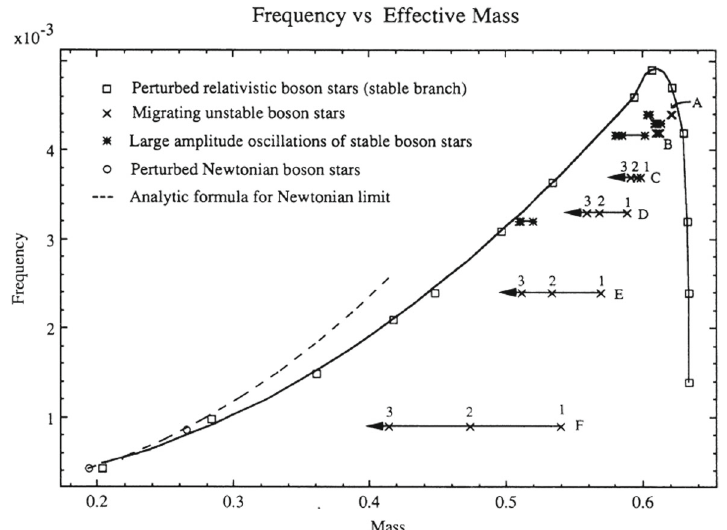
Fig. 12 Oscillation frequencies of various boson stars are plotted against their mass. Also shown are the oscillationfrequenciesofunstableBSsobtainedfromthefullynonlinearevolutionofthedynamicalsystem. Unstable BSs are observed maintaining a constant frequency as they approach a stable star configuration. Reprinted with permission from Seidel and Suen (1990); copyright by